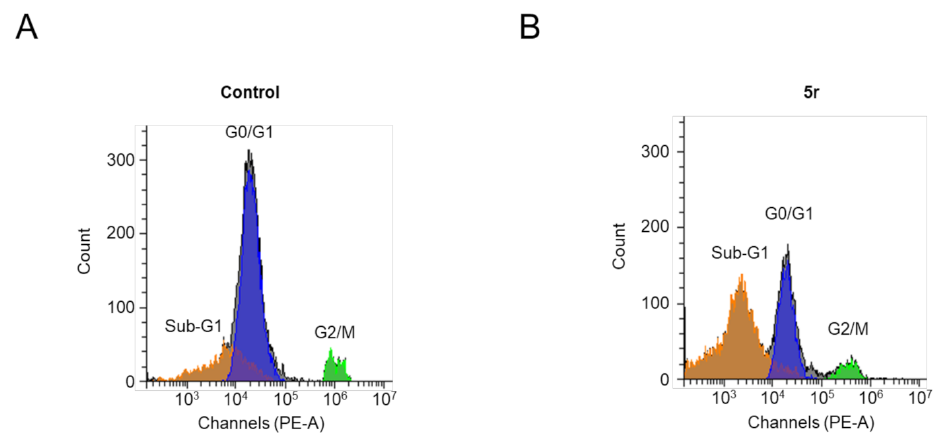
Figure 5. Effect of 5r on cell cycle in HepG2 cells. ( A , B ) HepG2 cells were treated with 3 µ M 5r for 24 h and then cell cycle phases were measured by propidium iodide staining, followed by flow cytometry